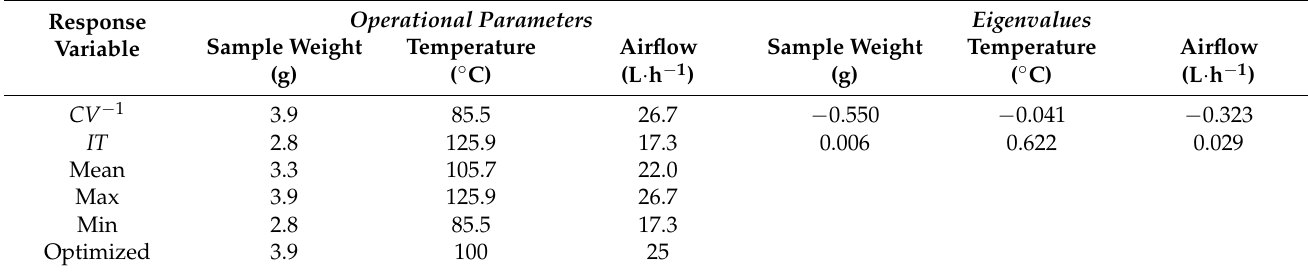
Table 4. Stationary maximized points in original units for each non-linear response variable